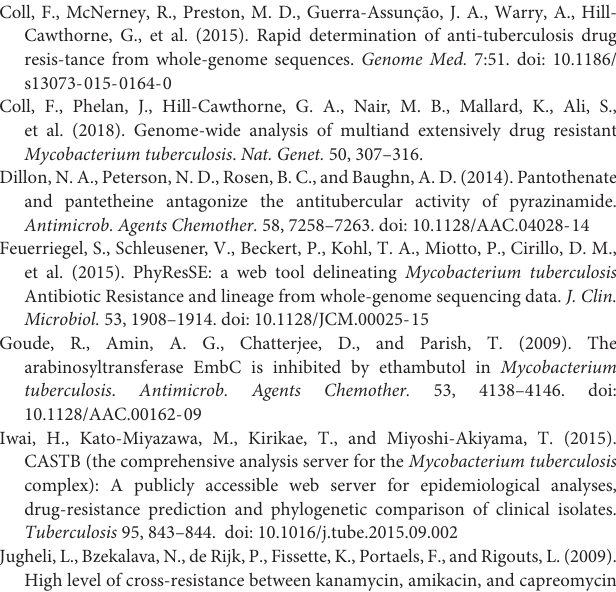
TABLE S1 | ReSeq data set. TABLE S2 | Validation data set. TABLE S3 | Occurrence of non-predictive mutation in the ReSeq and validation data set. TABLE S4 | Comparison of PointFinder and